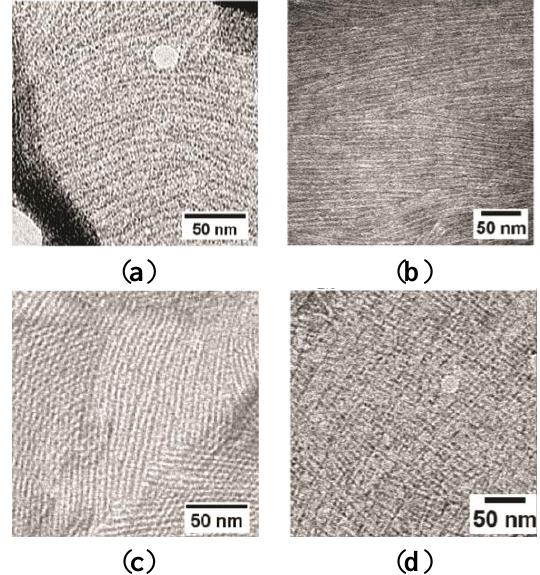
Figure 2. TEM image of negatively stained DewA and EAS layers transferred from the surface of droplets of solutions containing: ( a ) DewA 15% ( v / v ) ethanol; ( b ) EAS 15% ( v / v ) ethanol; ( c ) DewA 25% ( v / v ) ethanol; and ( d ) EAS ∆15 ( v / v ) ethanol after incubation at room temperature for 20